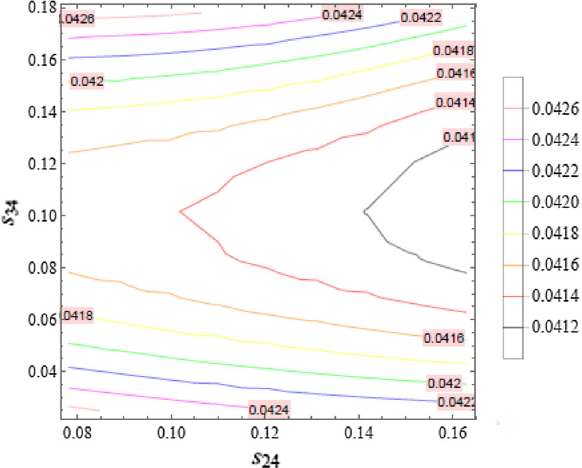
Fig. 5 | n u | versus s 24 and s 34 with s 24 ∈ ( 0 . 0782 , 0 . 163 ) and s 34 ∈ ( 0 . 025 , 0 . 178